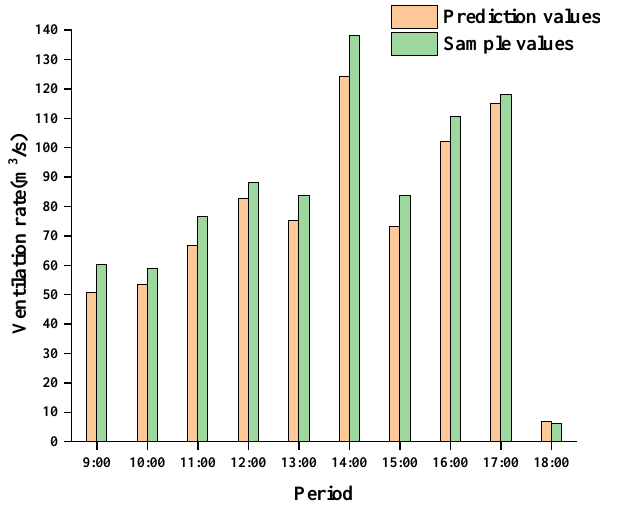
Figure 21. Comparison of the fitted and sample values in the high-altitude area.